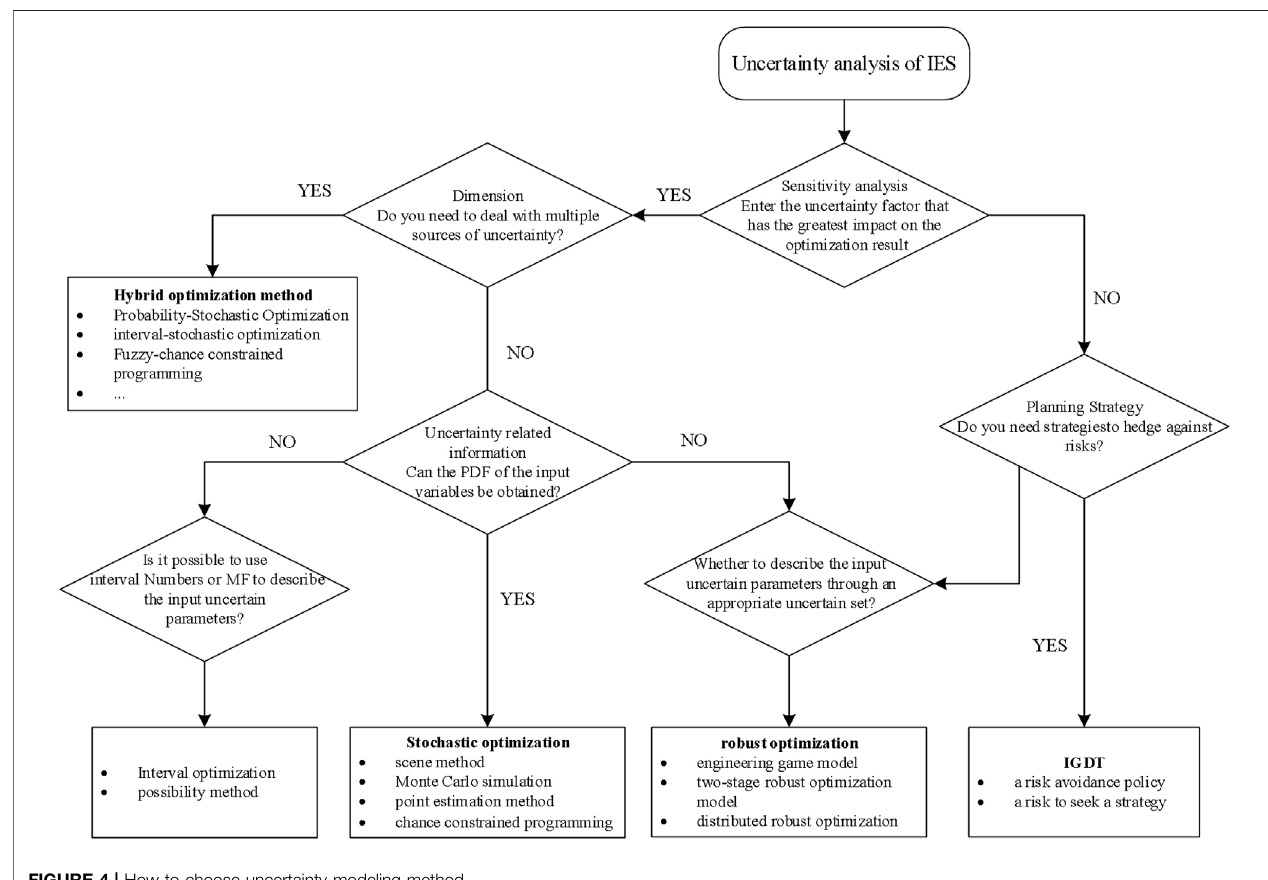
FIGURE 4 | How to choose uncertainty modeling method.